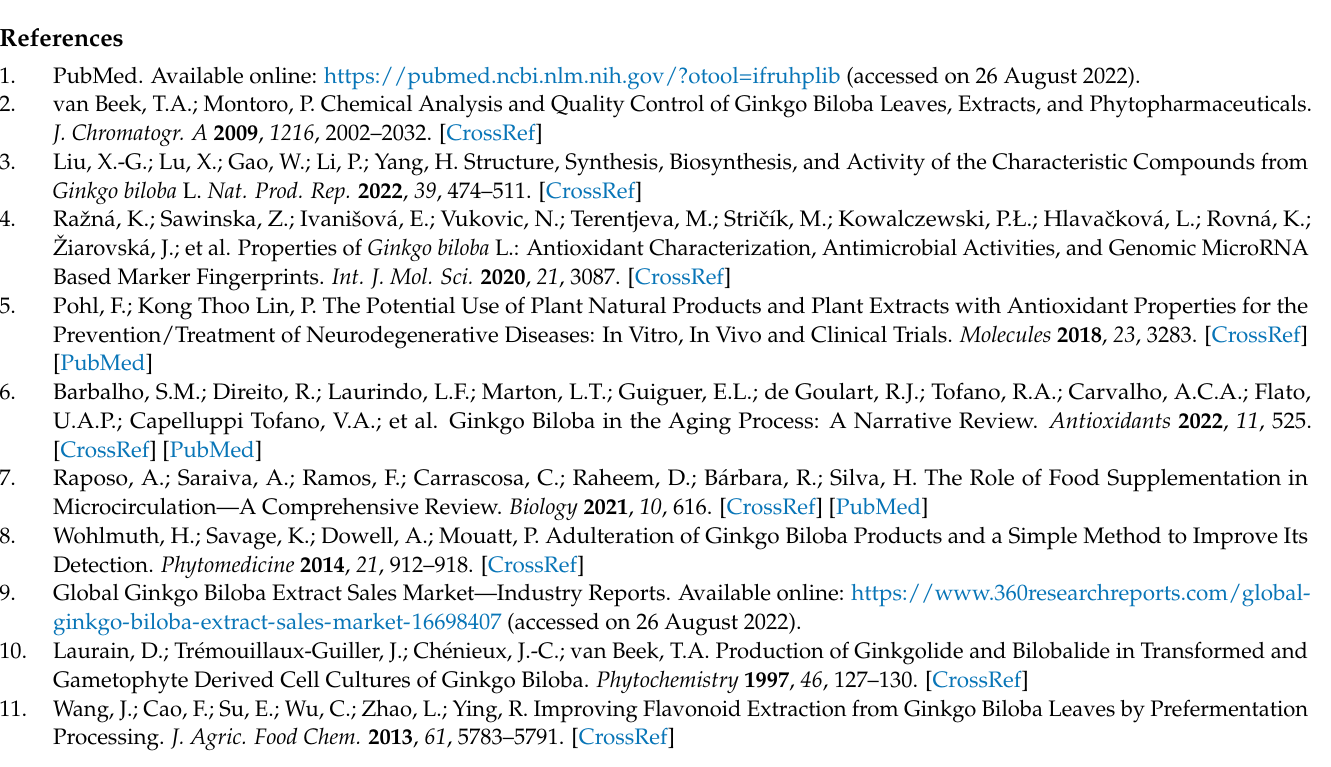
grapholide. Figure S2: calibration curve for bilobalide (BB) quantification. Figure S3: calibration curve for Ginkgolide A (GA) quantification. Figure S4: calibration curve for Ginkgolide B (GB) quantification. Figure S5: calibration curve for Ginkgolide C (GC) quantification. Figure S6: LC-HR- ESI-MS chromatogram for standards reference in a fortified mixture. Figure S7: ESI-MS ionization patterns of terpene trilactones: bilobalide, ginkgolide A, ginkgolide B, ginkgolide C and a reference standard,